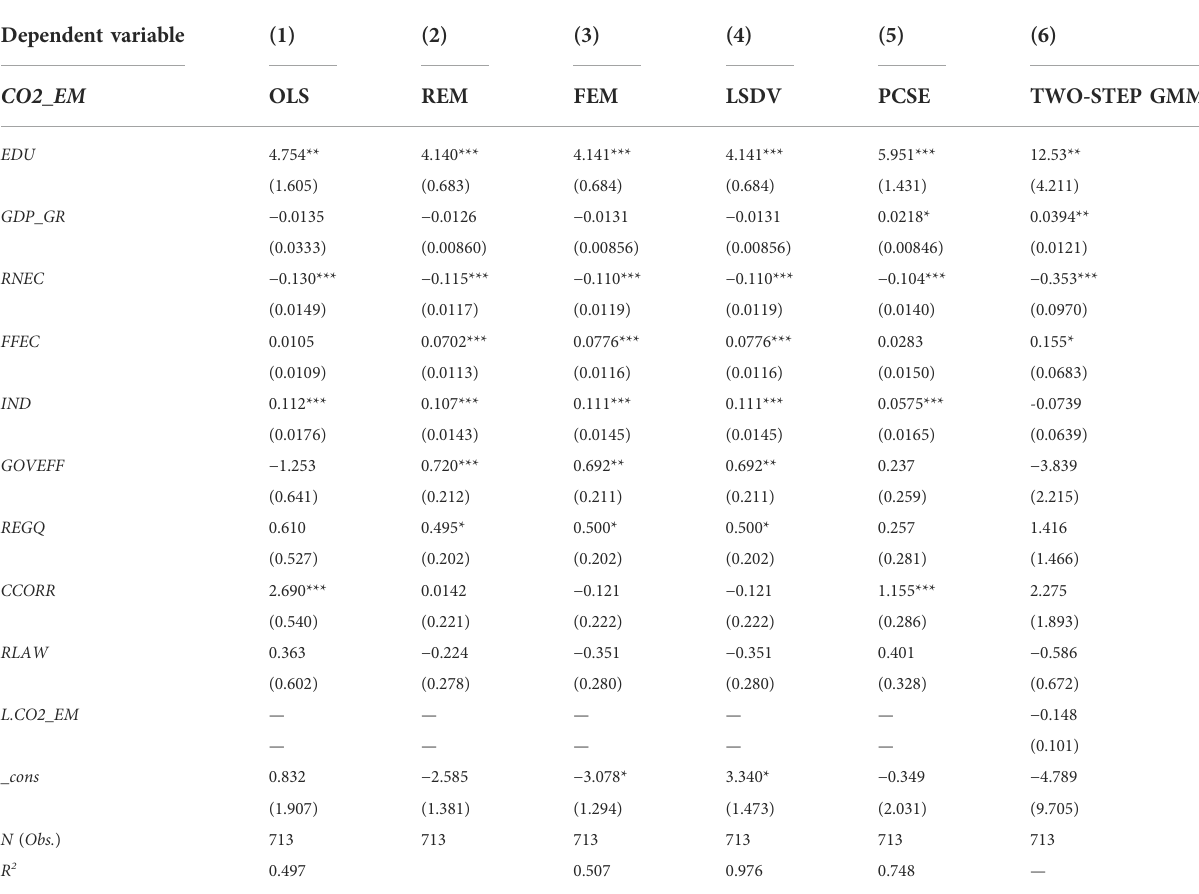
TABLE 5 Regression